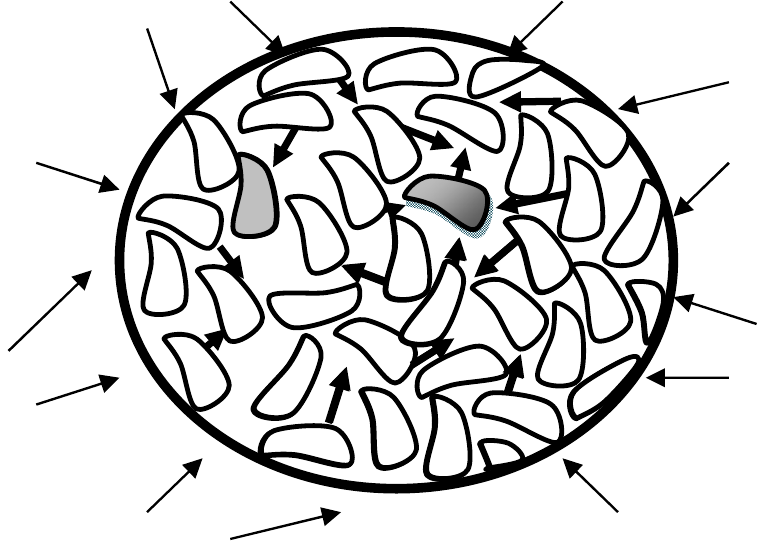
Figure 1. Diffusion process (schematic—2D view). The long arrows in Figure 1 symbolize the transfer of temperature energy by external impulses of gas molecules or radiation coming from all directions in irregular intervals, stimulating the molecules of the liquid matter to vibrate inharmoniously. The vibration frequencies and amplitudes are distributed around a mean value. The short arrows demonstrate that the molecular centers and the axes may tend to move in different directions (the drawn vectors are not arranged correctly). The drawn molecules demonstrate the field limitations.